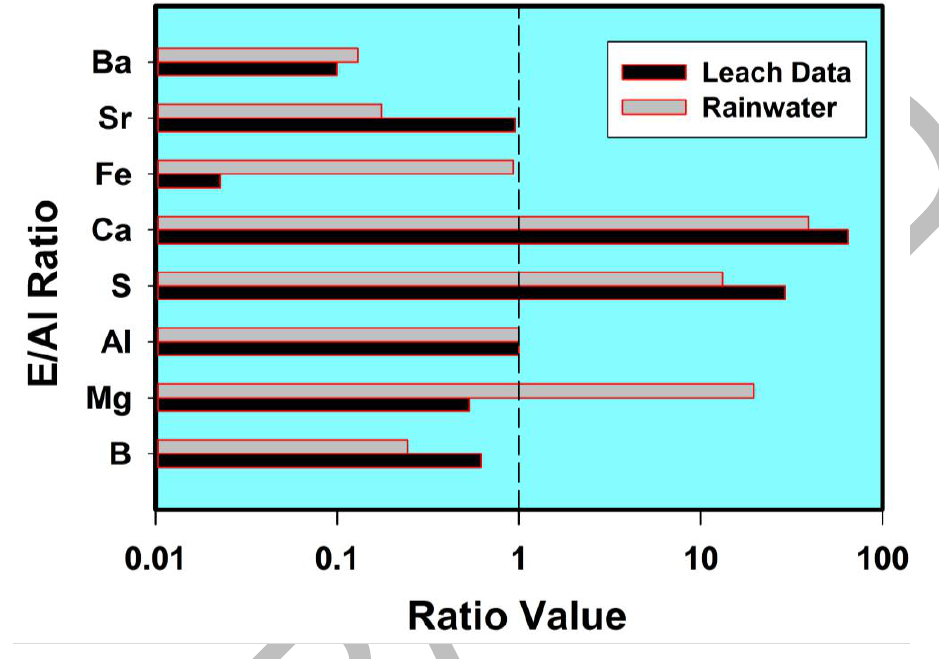
Figure 3. The chemical concentrations of 8 elements, normalized to aluminum, measured in post-aerosol-spraying San Diego rainwater for comparison with similar average element ratios in the leachate of coal fly ash from Figure 1. This figure shows that post-spraying rainwater leached the same elements, in similar proportions, to the elements leached from coal fly ash in laboratory investigations [10]. This is strong evidence that the substance emplaced into the troposphere is coal fly ash. At a 99% confidence interval, the two sets of data have the same mean (T-test) and the same variance